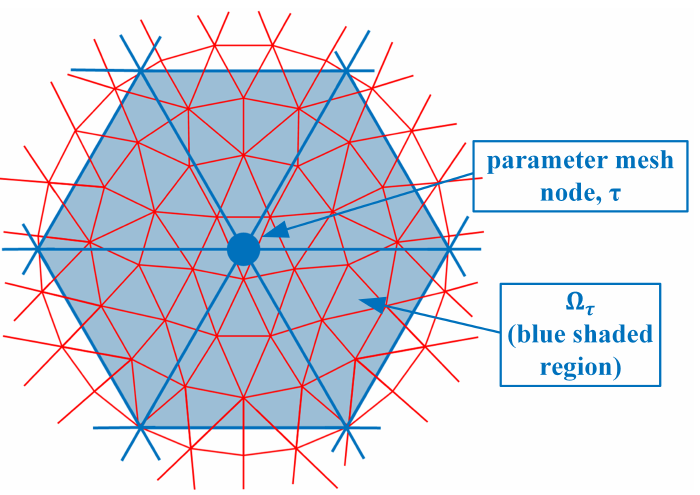
Figure 3. Parameter mesh nodes; example of node τ and corresponding region Ω τ is